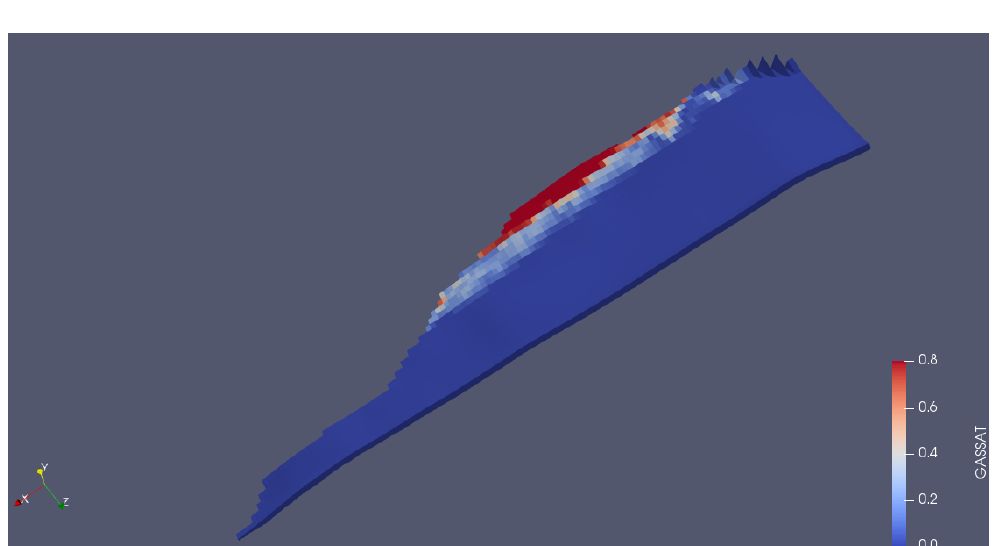
Figure 20. Gas saturation distribution in the reservoir (day 1770).